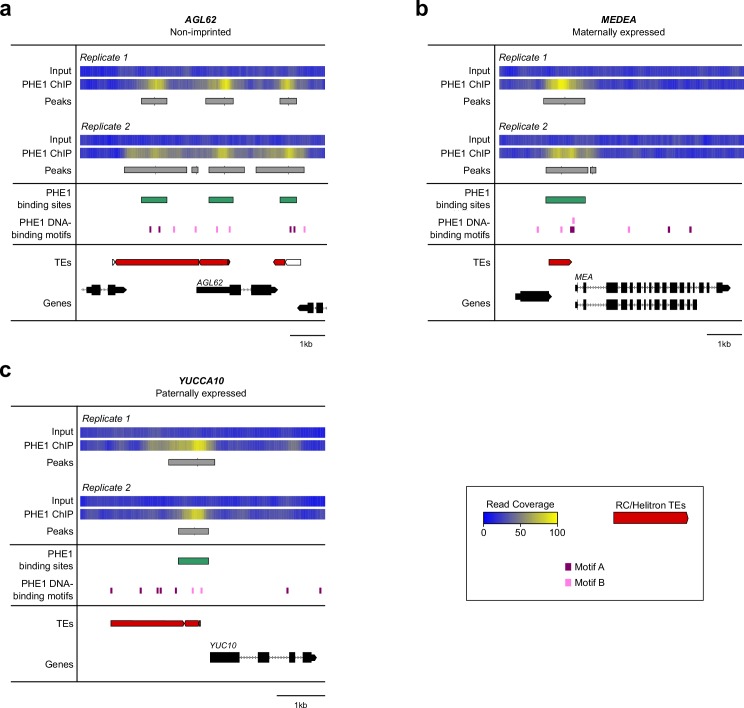
Examples of ChIP-seq read, peak, and motif distributions in PHE1 targets.For each target gene, the read coverage for Input (as control) and PHE1–GFP ChIP samples of each replicate is shown. Called peaks in each replicate are indicated by the grey boxes. PHE1 binding sites, identified from the overlapped peak regions for replicates 1 and 2, are represented by the green boxes. PHE1 DNA-binding motifs are those defined in Figure 3a, and are represented here by the purple (Motif A) and pink boxes (Motif B). Transposable elements in the vicinity of the target gene are indicated. Red boxes correspond to TEs of the RC/Helitron superfamily, whereas white boxes represent TEs of other superfamilies. For this analysis, three different PHE1 targets with distinct imprinting statuses were selected: (a) AGL62 – non-imprinted; (b) MEDEA – a maternally expressed gene; (c) YUCCA10 – a paternally expressed gene.